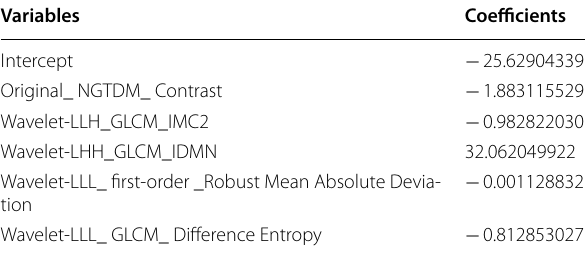
Table 4 Coefficients for the calculation of the selected radiomics